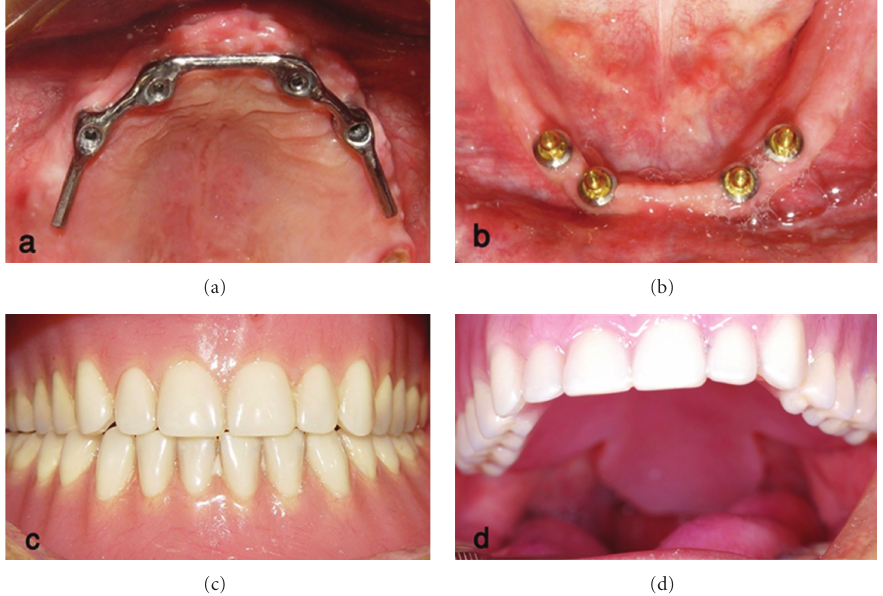
Figure 4: (a) Occlusal view of maxillary bar attachment. (b) Occlusal view of mandibular ball attachment. (c) Frontal view of maxillary and mandibular denture in centric occlusion. (d) Maxillary denture and palatal lift portion in